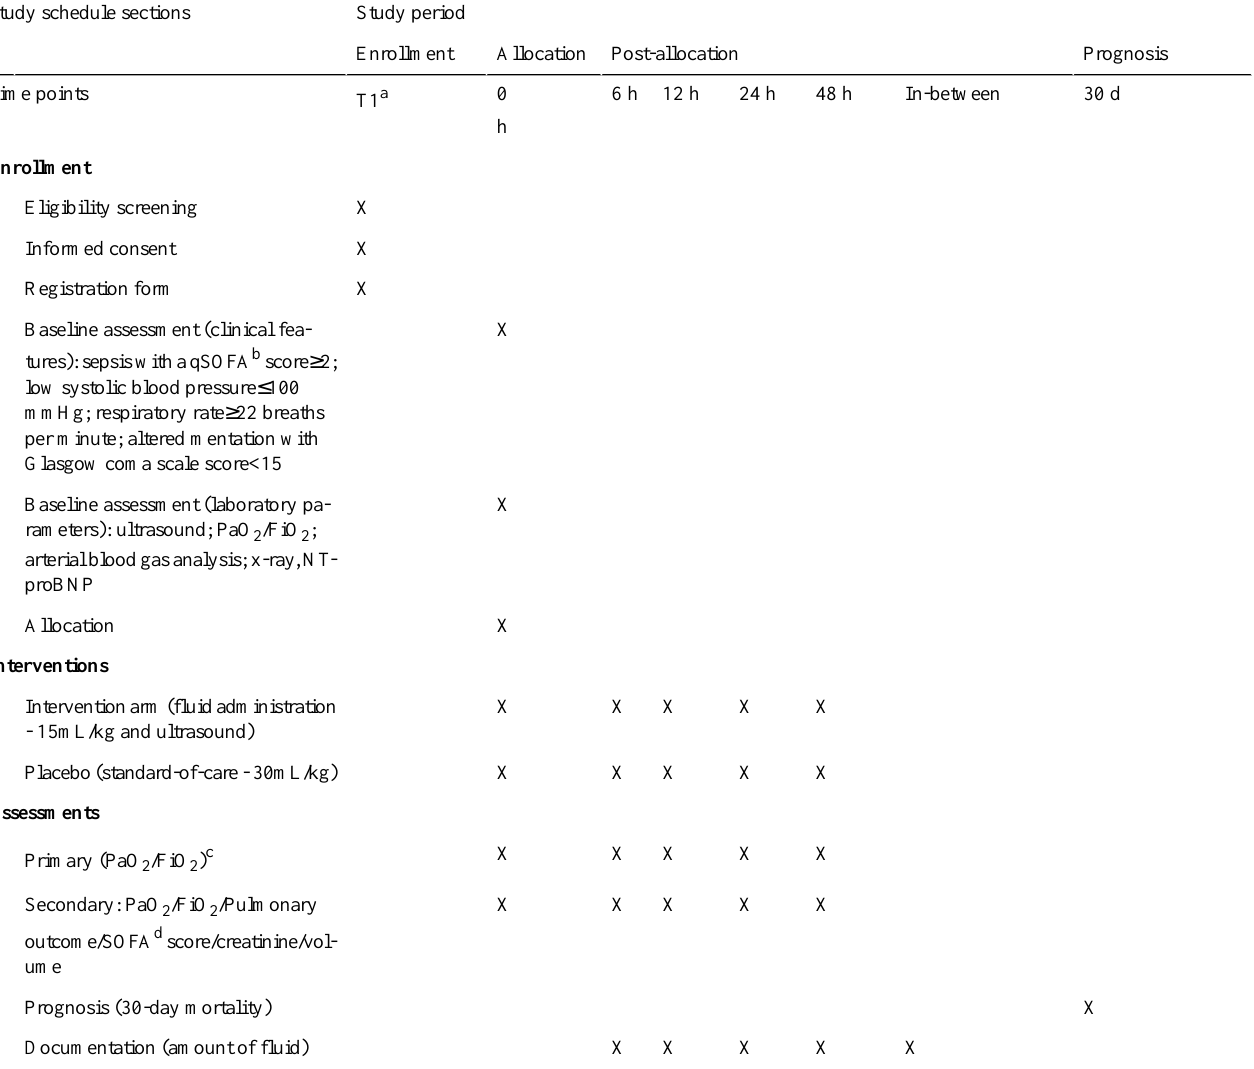
Table 1. SPIRIT-compliant schedule of enrollment, interventions and assessments.